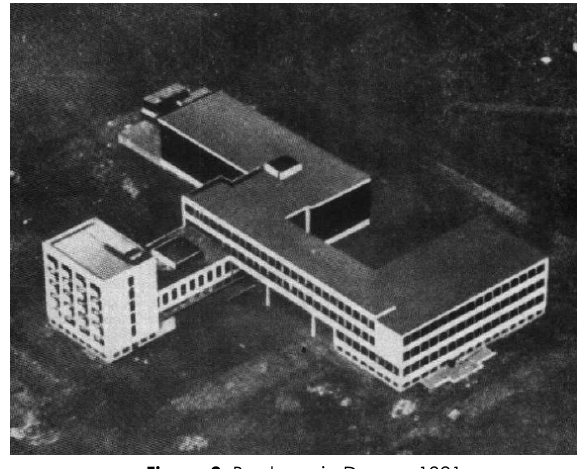
Figure 2 . Bauhaus in Dessau 1921